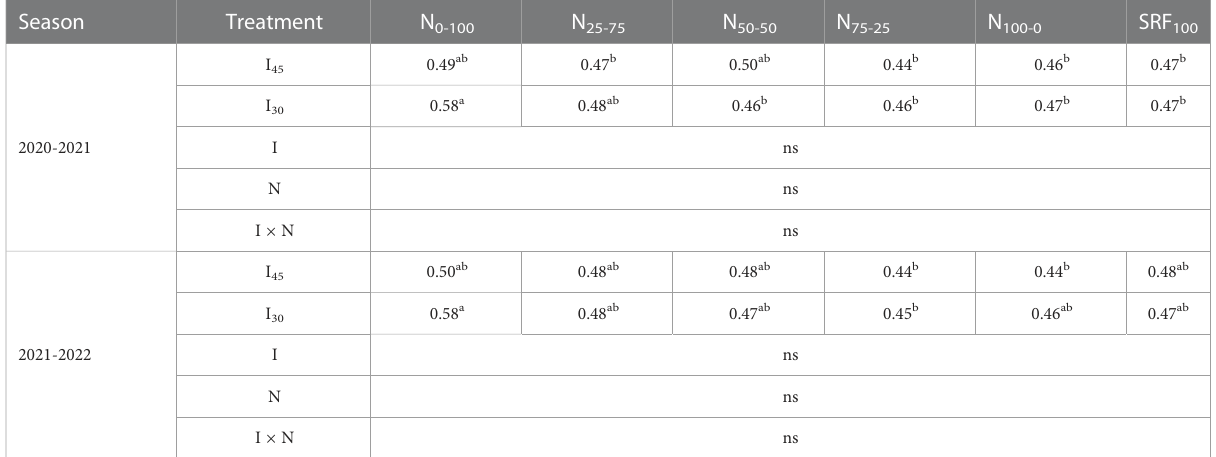
TABLE 6 In fl uence of different irrigation scheduling and nitrogen application modes on winter wheat harvest index during 2020-2021 and 2021- 2022 growing seasons.